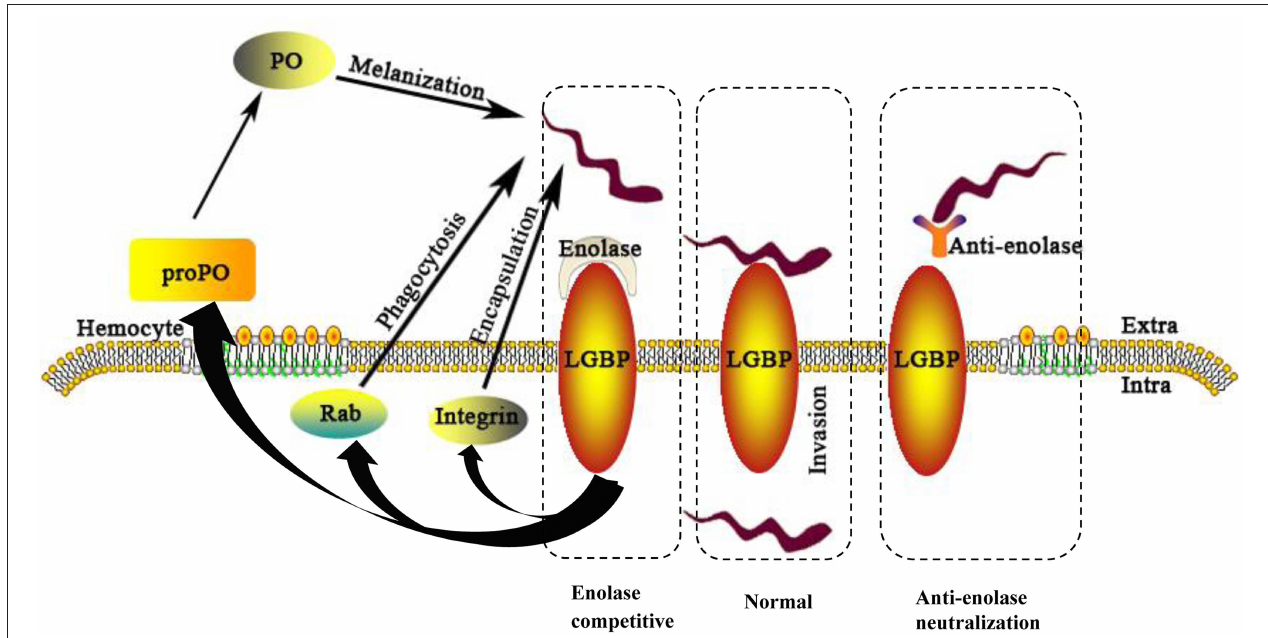
FIGURE 9 | A schematic model of the M. rosenbergii hemocytes immune reaction against S. eriocheiris infected. For abbreviations and explanation see the